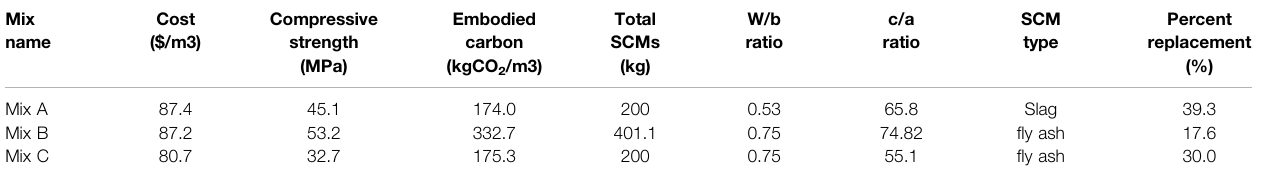
TABLE 7 | Three example concrete mixture designs for the Miami case study.